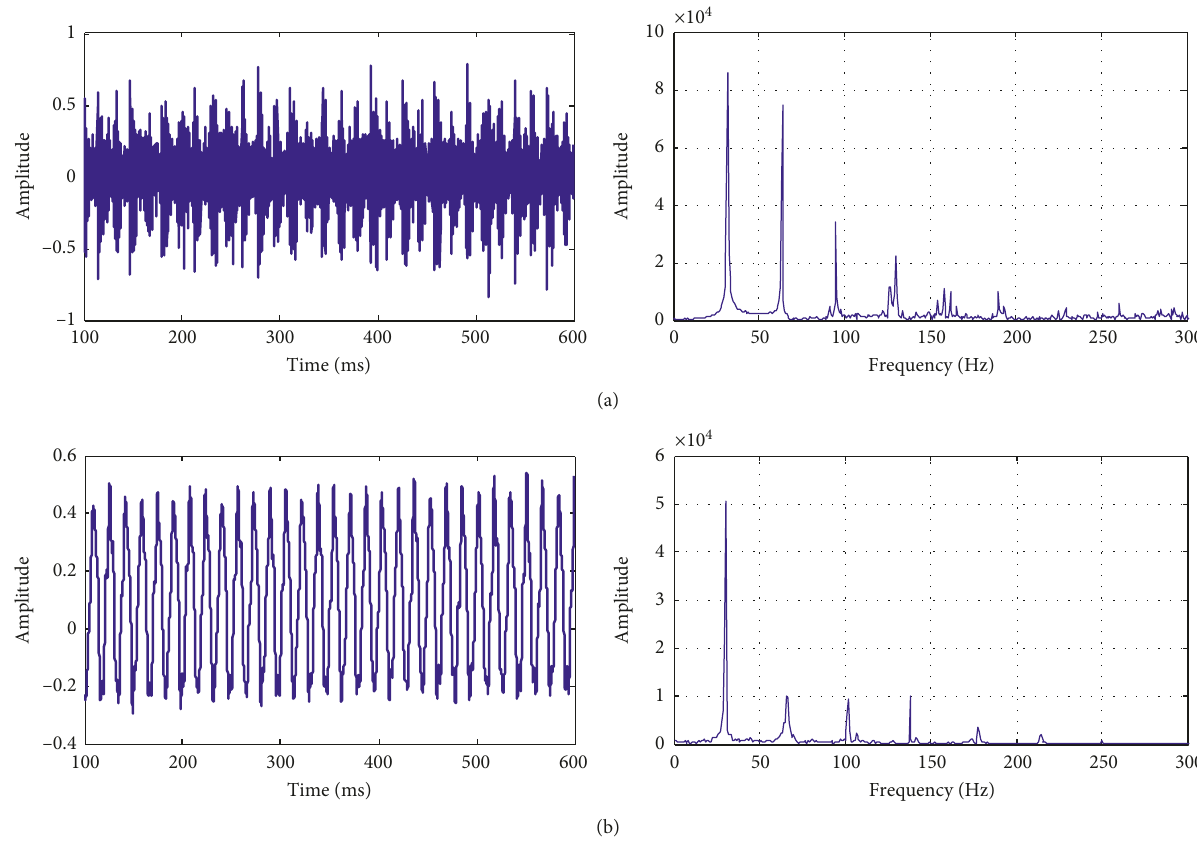
Figure 17: Vertical vibration amplitude signals and its frequency diagram on bearing without pedestal looseness. (a) Vibration amplitude signals and its frequency diagram. (b) Denosing vibration amplitude signals and its frequency diagram.